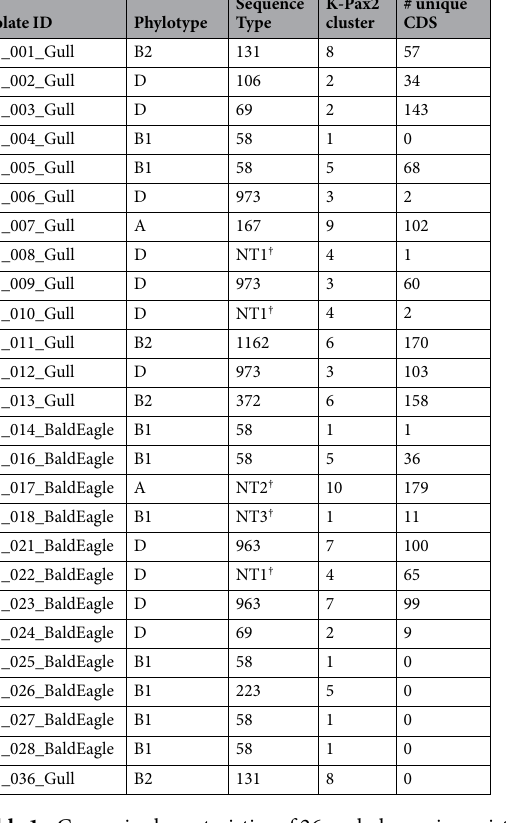
similar foraging behaviour by gulls and eagles at the landfill or pirating behaviour) or 2) through an inter-species transmission pathway (via faecal-oral route or predation of gulls by eagles). Further efforts are needed to under- stand the precise mechanisms by which cephalosporin-resistant E . coli may be shared among these sympatric taxa, and the potential implications this has for the spatial dissemination of AMR enteric bacteria by wild birds. All 10 MLST sequence types found in our study that could be assigned to an existing type have previously been isolated from humans - nine of which have caused human disease (http://enterobase.warwick.ac.uk). These 10 MLST sequence types found in gulls and bald eagles included globally widespread, clinically impor- tant E . coli sequence types, including the often-multi-drug resistant and pathogenic ST131 and ST69 clones 43–45 . ESBL-producing ST131 E . coli isolates have also been isolated from several wild and domestic animal species, including gulls in Barrow (now Utqiaġvik), Alaska 30 and Winnipeg, Canada 46 , the latter of which carried, among others, the two bla CTX-M genotypes found in our study ( bla CTX-M-14 and bla CTX-M-55 ). The two ST131 isolates from our study belonged to ST131 clade A and clade B, with the clade A isolate harbouring acquired ESBL genes bla CTX-M-14 and bla TEM . This supports previous findings that bla CTX-M-14 is associated with clades A and C1 and that bla CTX-M genes are rarely found in clade B isolates 47 . CTX-M enzymes hydrolyse a wide variety of newer generation β -lactam antibiotics 48 and have been increasing in incidence globally. CTX-M-14 and CTX-M-15 genotypes are particularly widespread, and the prevalence of CTX-M-55 is increasing in China 49 . The isolate in our study with the highest number of resistant genes, A1_007_Gull, belonged to ST167. In clinical human derived isolates, ST167 has been found to harbour resistance genes to last-line of defense antibiotics, such as carbapenems and colistin 50 . However, we did not find evidence for resistance to these two antibiotics in the ST167 gull isolate recovered in our sample collection. Additional WGS of E . coli isolates from humans and birds, com- bined with MLST results, would be useful for providing further inference as to the utility of commonly employed genetic approaches (e.g., MLST) for elucidating potential epidemiological connections across the human-animal interface. The cephalosporin-resistant E . coli sequence types and AMR gene alleles found in gulls and bald eagles in our study have previously been reported to be widespread, making it difficult to identify specific sources for these iso- at the mouth of the Kenai River or more spatially-distant samples collected from Middleton Island 21 . Thus, it is plausible that the Soldotna landfill either serves as a point source for cephalosporin-resistant E . coli or at least pro- vides selection pressures to maintain AMR E . coli in the environment. This inference is substantiated by previous research that found increased AMR bacteria in gulls foraging in anthropogenic environments 51 .